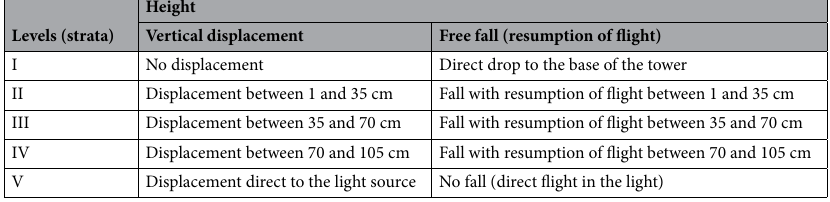
Table 4. Levels (strata) for the vertical displacement and free fall (resumption of flight) test of Africanized honey bees Apis mellifera